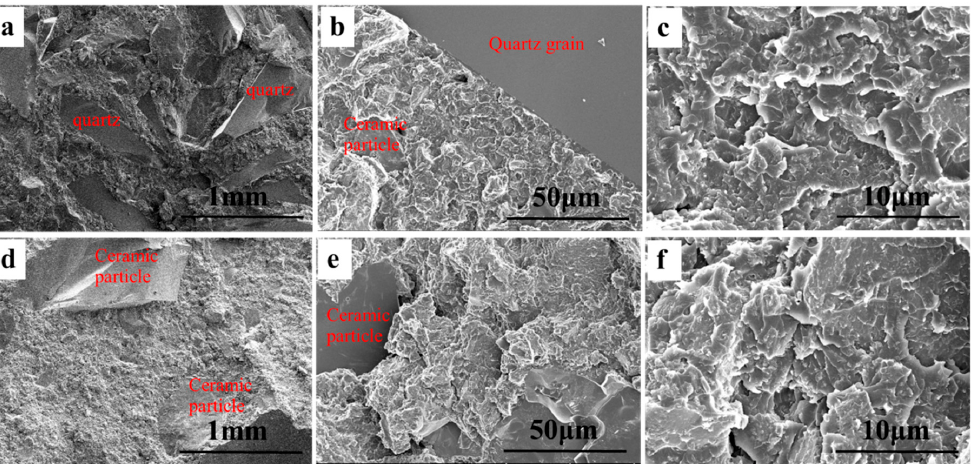
Figure 8. Cross-sectional SEM images of obtained ( a – c ) A3 and ( d – f ) B3 artificial stones with 45% ceramic waste at different magnifications.